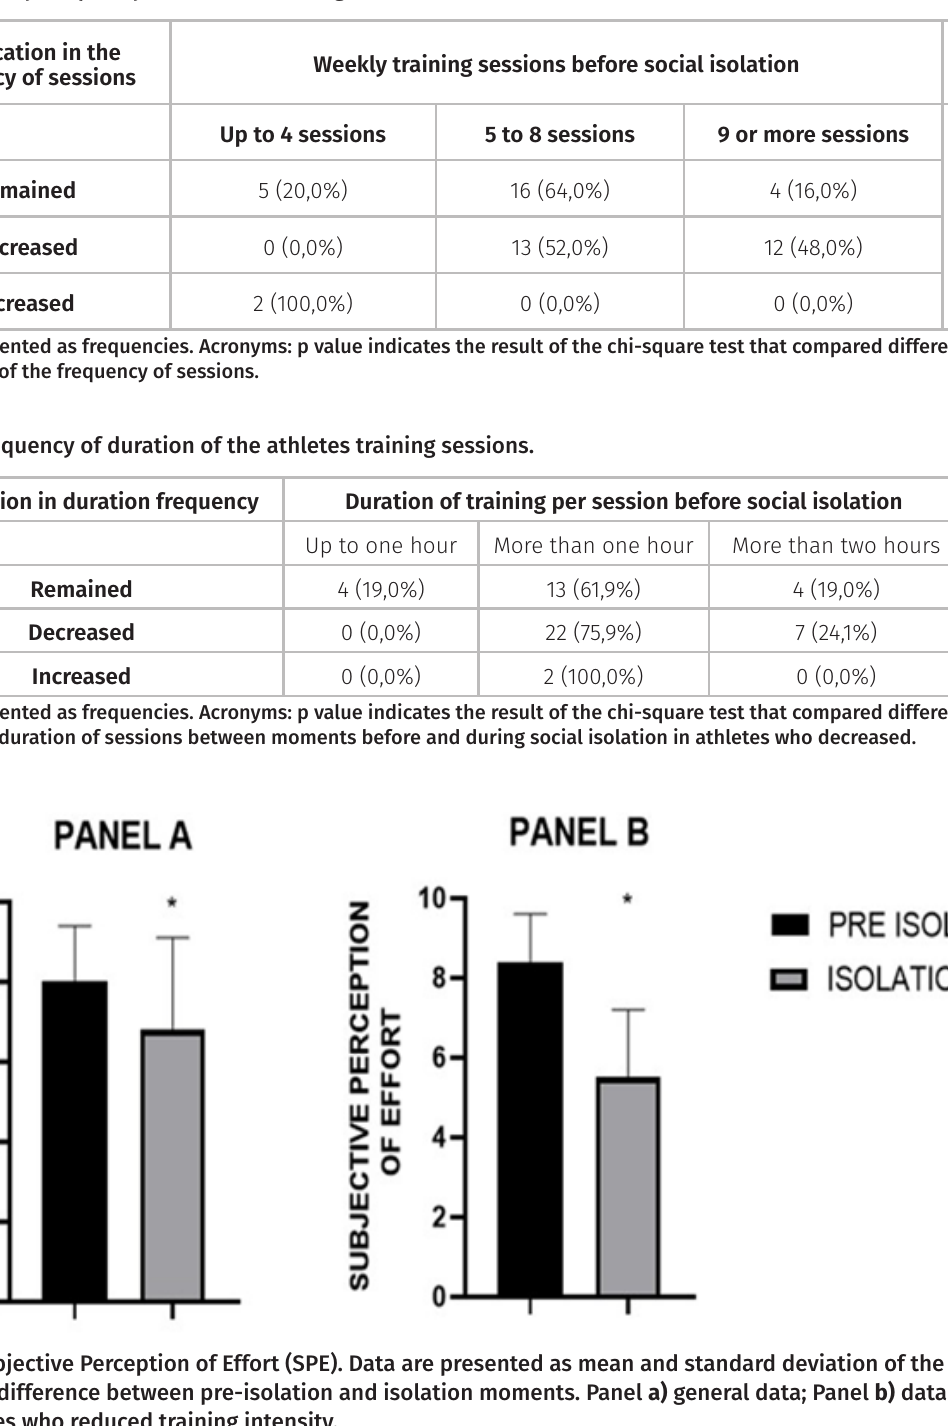
Table II. Weekly frequency of athletes training sessions.